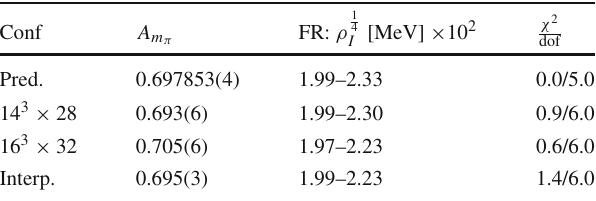
lines indicate the fitting results of the predictions, the numerical results of V = 14 3 × 28, and V = 16 3 × 32, respectively. In the right figure, the black full line and the blue full line indicate the fitting results of the prediction and the interpolated results, respectively